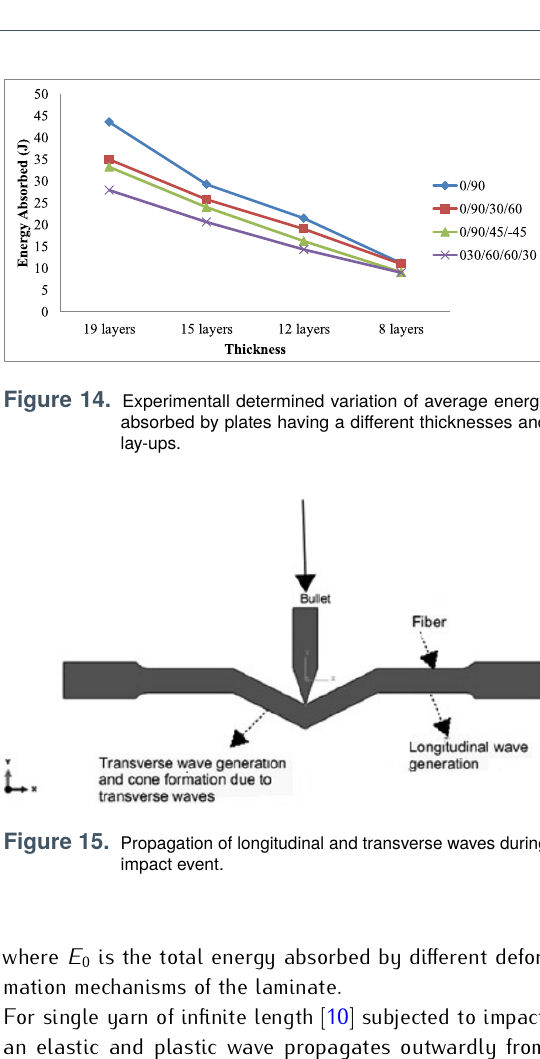
where E 0 is the total energy absorbed by different defor- mation mechanisms of the